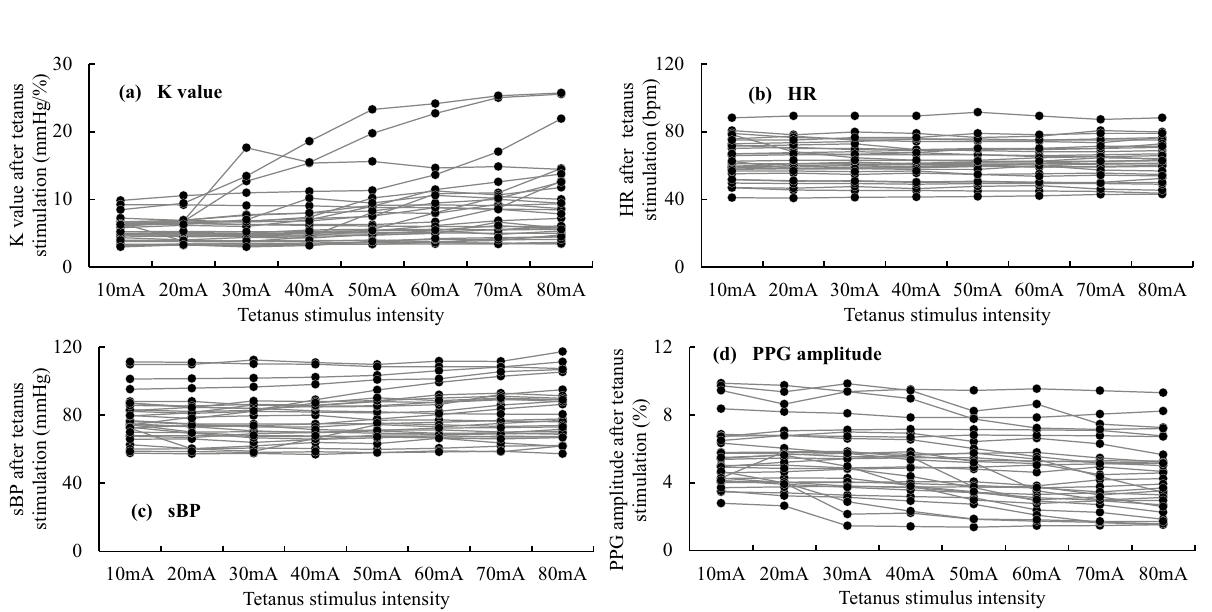
Figure 3. vascular stiffness value (K), systolic blood pressure (sBP), heart rate (HR), and photoplethysmography amplitude (PPG) after tetanus stimulation at each intensity. There were many cases in which the value of K increased with increasing stimulus intensity. However, when the stimulus intensity was large, individual differences in the K change tended to be large. Values of PPG amplitude tended to decrease with increasing stimulus intensity. In many cases, there was no obvious change in HR even when the stimulus intensity was